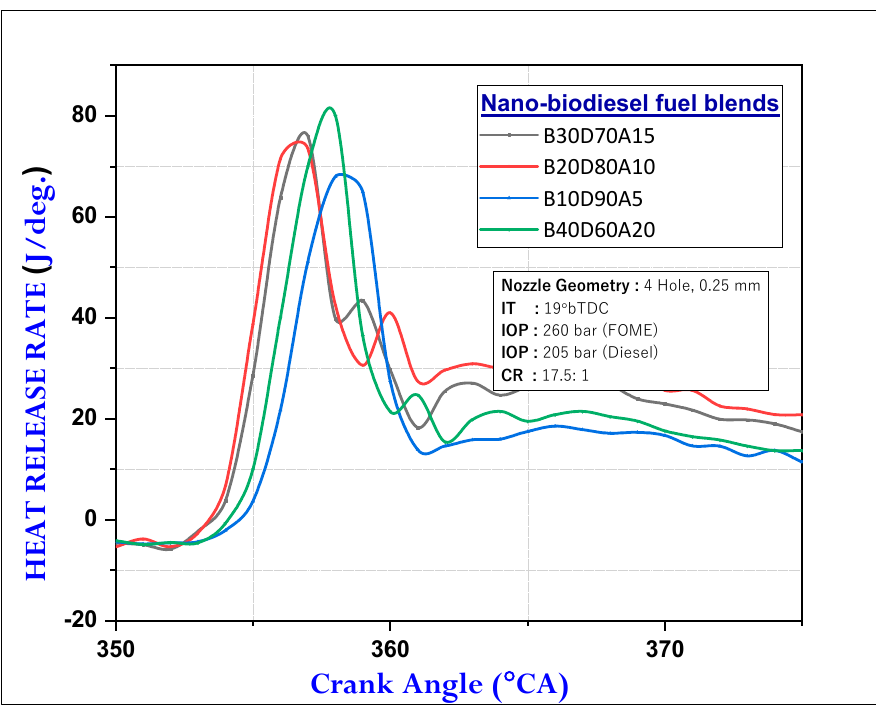
Figure 14. Variation in heat release rate with crank angle at 100% load.